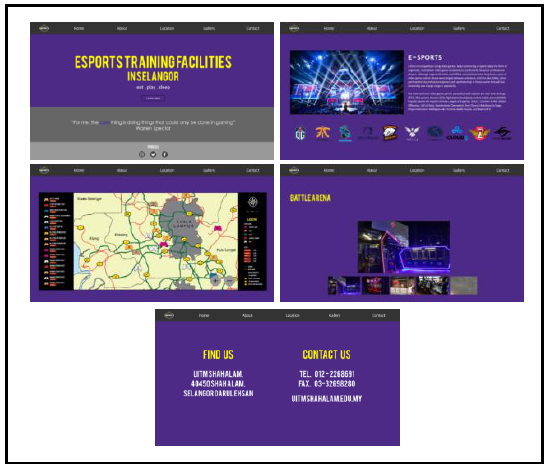
Figure 3. E-sports system created by using Adobe Flash